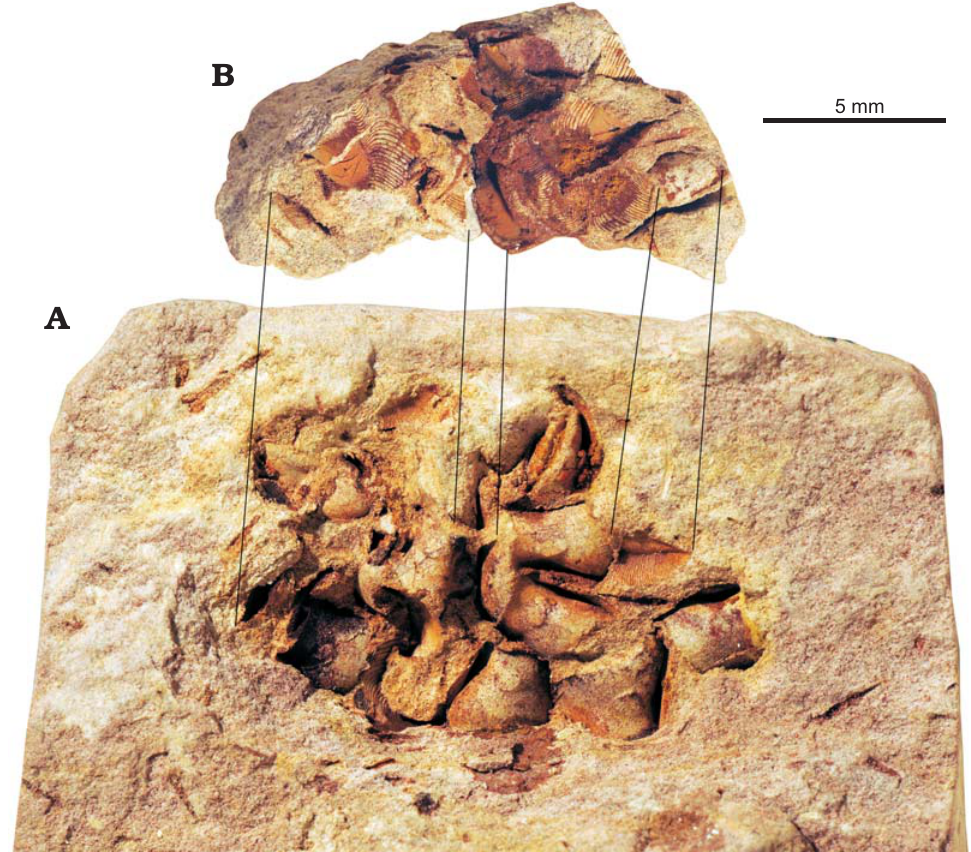
Fig. 1. Machaeridian annelid Lepido- coleus kuang guoduni sp. nov., Nandan Formation, Eifelian, near Napiao, Guan gxi (China). A . The main plate containing most machaeridian scler- ites. B . The counterplate of the same specimen (it was glued back onto the slab prior to CT-scanning); note the limonitic filling of the rugae and the chaotic arrangement of the